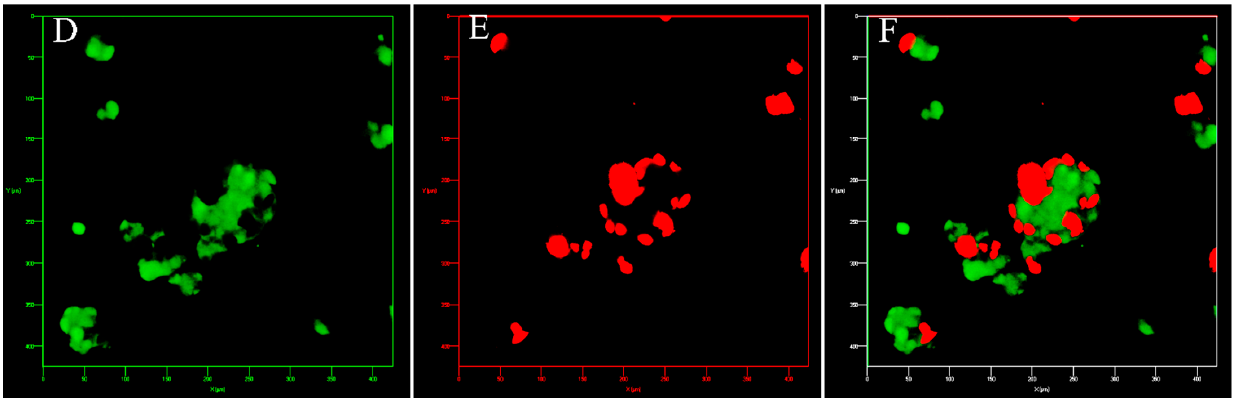
Figure 3. Three-dimensional Z-stacked image of co-cultured Hep-G2 and HUVEC clusteroids at a cell ratio of ( A – C ) 1:1 and ( D – F ) 5:1 set at different fluorescence channels: FITC ( A , D ), CFSE far-red ( B , E ), and dual fluorescence ( C , F ). The box size is 400 μ m × 400 μ m.